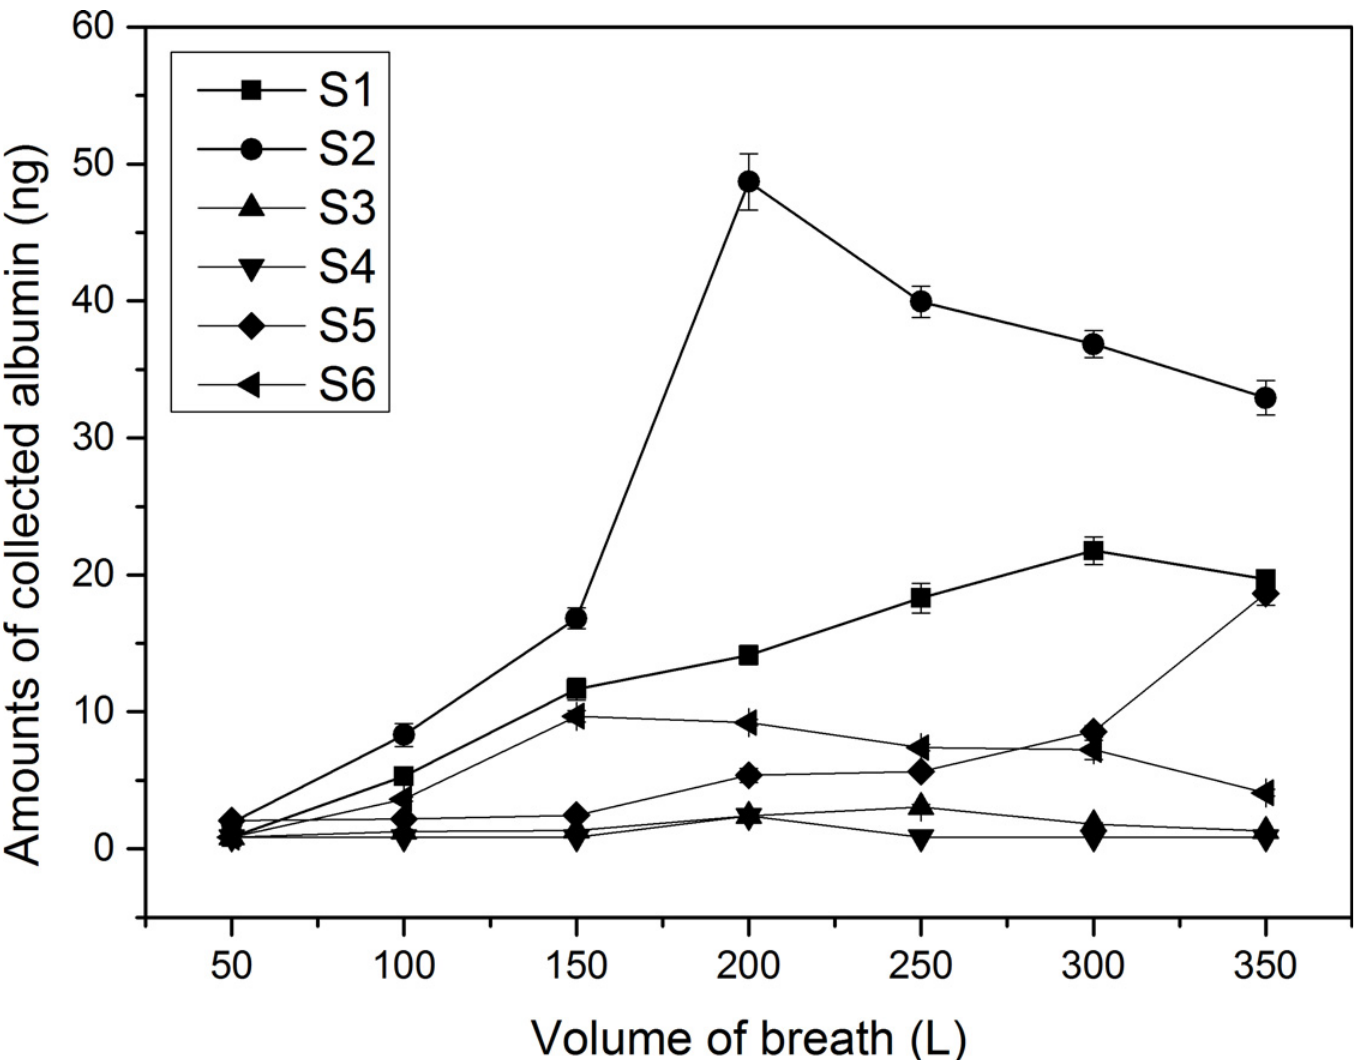
Fig 5. Amounts of albumin in human exhaled breath collected using self-designed collecting devices. The amounts of collected albumin were calculated by Eq 2. Error bars shown in the figure were standard deviation of triplicate measurements of each